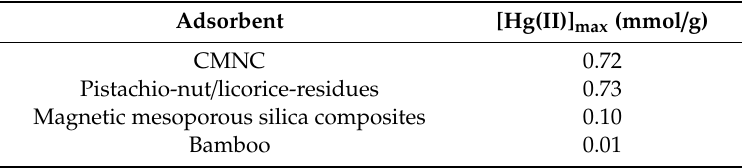
Table 4. Comparison of monolayer adsorption capacity of various